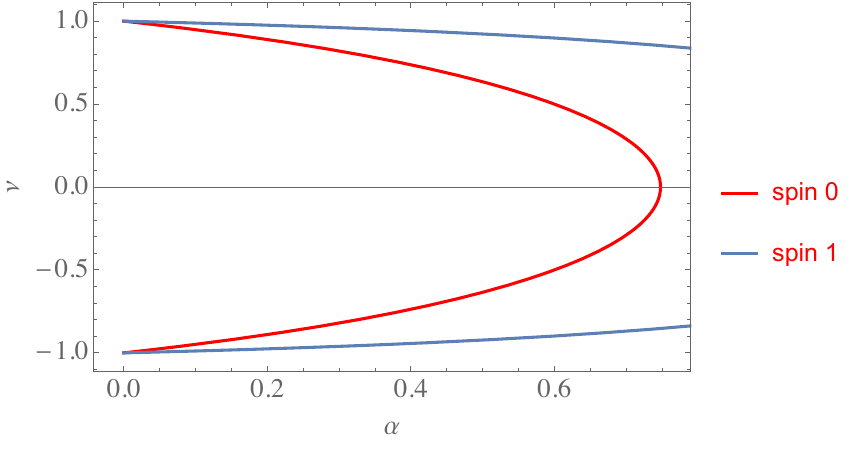
Figure 2 . The scaling dimension (cid:23) ( (cid:11) ) in the spin 0 and 1 form factors when m = 0. (cid:23) ( (cid:11) ) for the two sectors are displayed in (cid:12)gure 2, and in the spin 0 case (cid:23) ( (cid:11) ) is